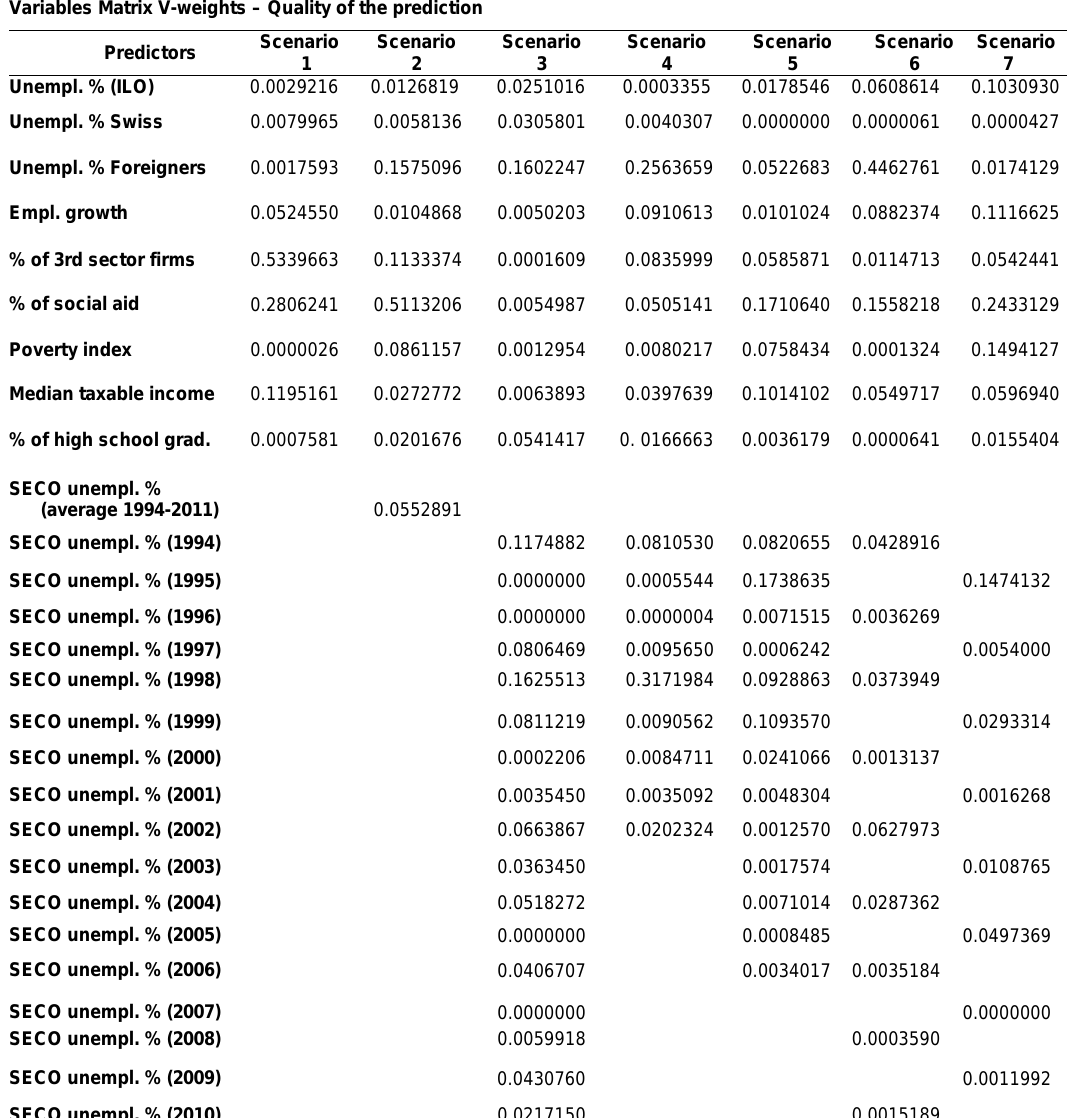
Table 3. Predictor V-weights in defining the SC from the cantons in the donor pool. Variables Matrix V-weights – Quality of the